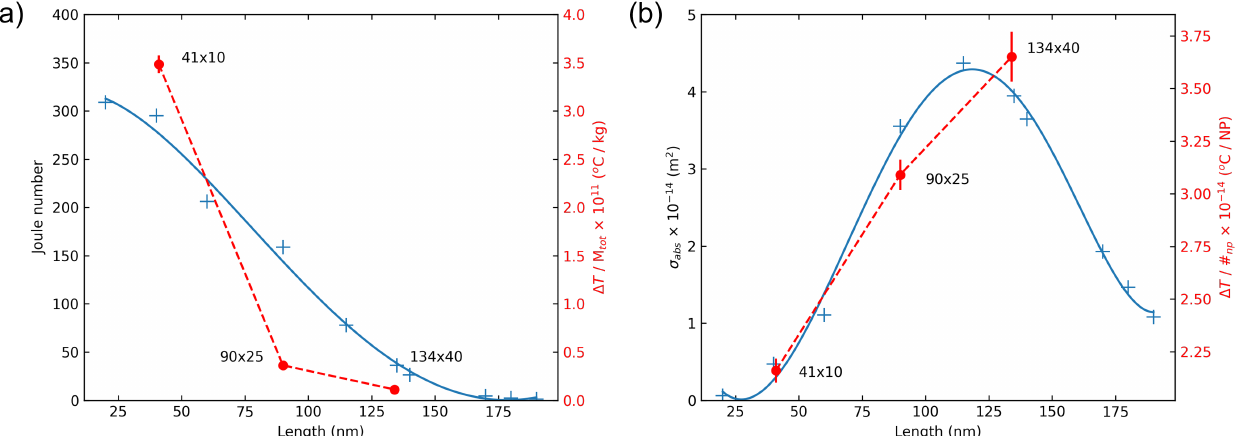
Figure 4. ( a ) Measured global temperature change divided by the total mass of gold of each sample (red dashed line). For the same amount of gold, the total temperature rise follows the Joule number (blue line). ( b ) Measured global temperature change divided by the total number of NPs in each sample (red dashed line). For the same number of NPs, the total temperature rise follows the absorption cross-section (blue line).